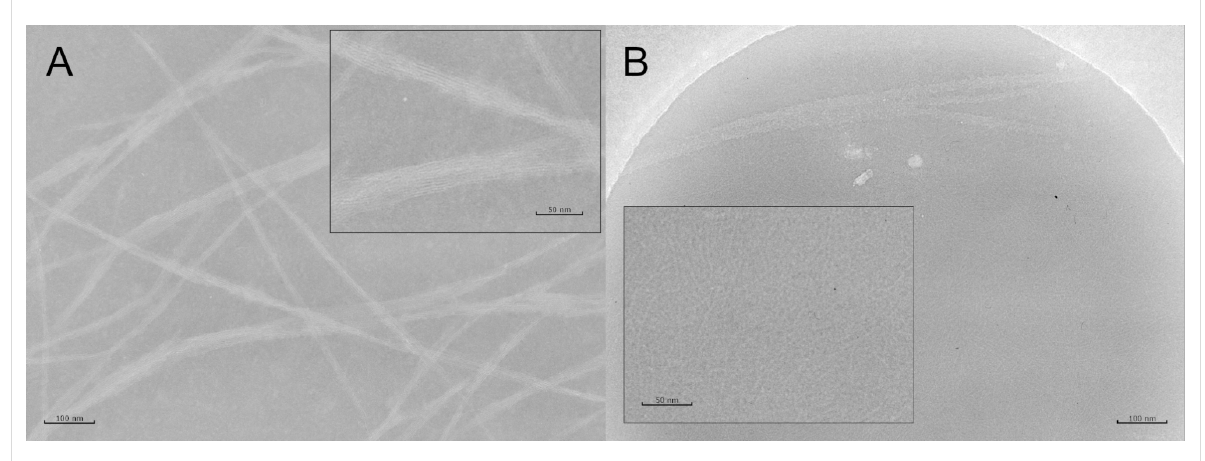
Figure 3: (A) TEM of 100 µM R2A2 in 10 mM Tris/HCl buffer, pH 9. Sample was negative stained with 2% PTA; defocus − 0.5 µm. (B) Cryo TEM of 100 µm R2A2 in 10 mM Tris/HCl buffer, pH 9; defocus − 1.8 µm.